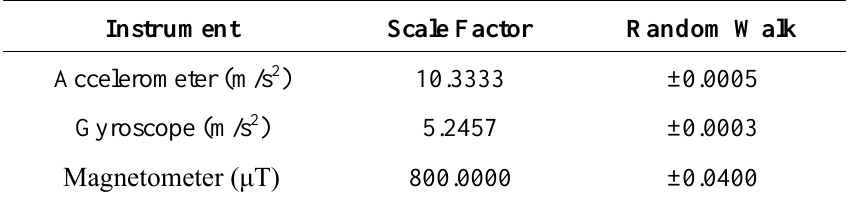
Table 3. Technical specifications of the